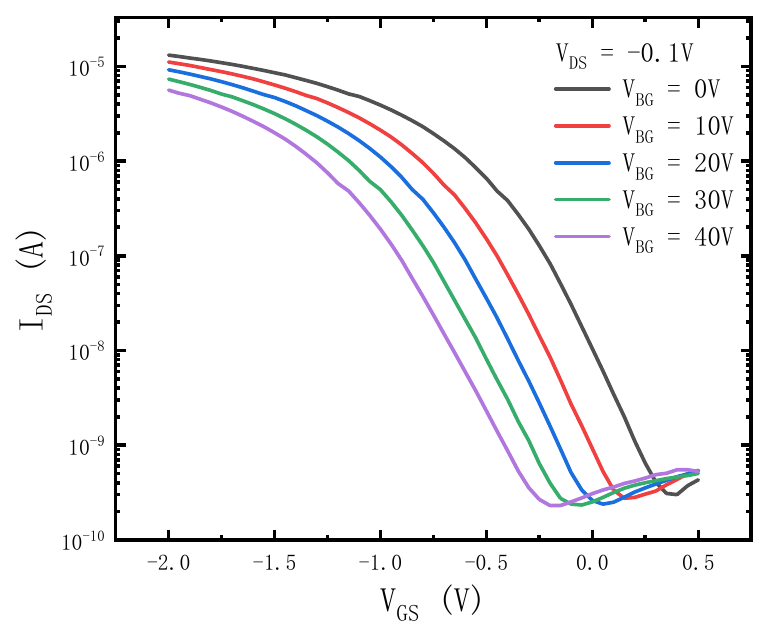
Figure 4. I DS -V GS characteristics of devices at different substrate voltages.